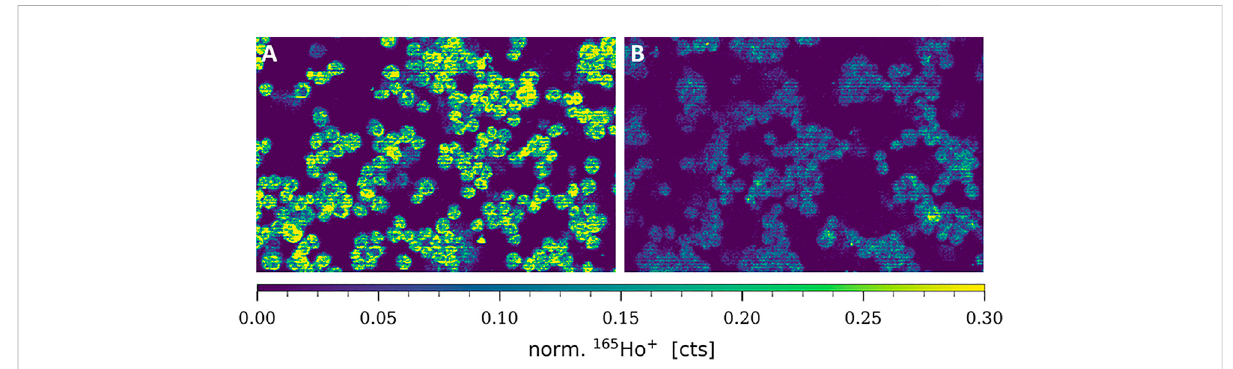
FIGURE 2 Signal intensity maps of 165 Ho + , showing normalized cellular levels of total CTR1 in (A) A2780 and (B) A2780cis. Cytospin samples were measured by LA-ICP-TOFMS imaging at the single-cell level.